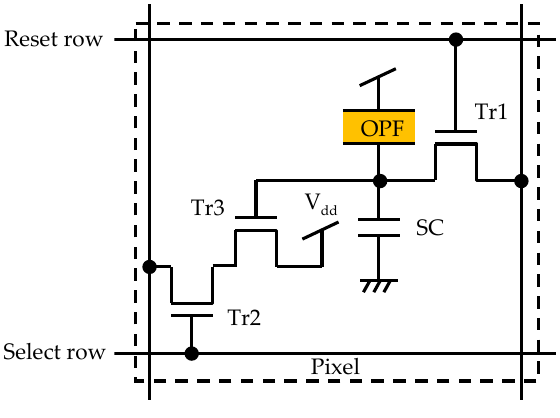
Figure 2. A cross sectional view of an organic photoconductive film (OPF) CMOS imager.